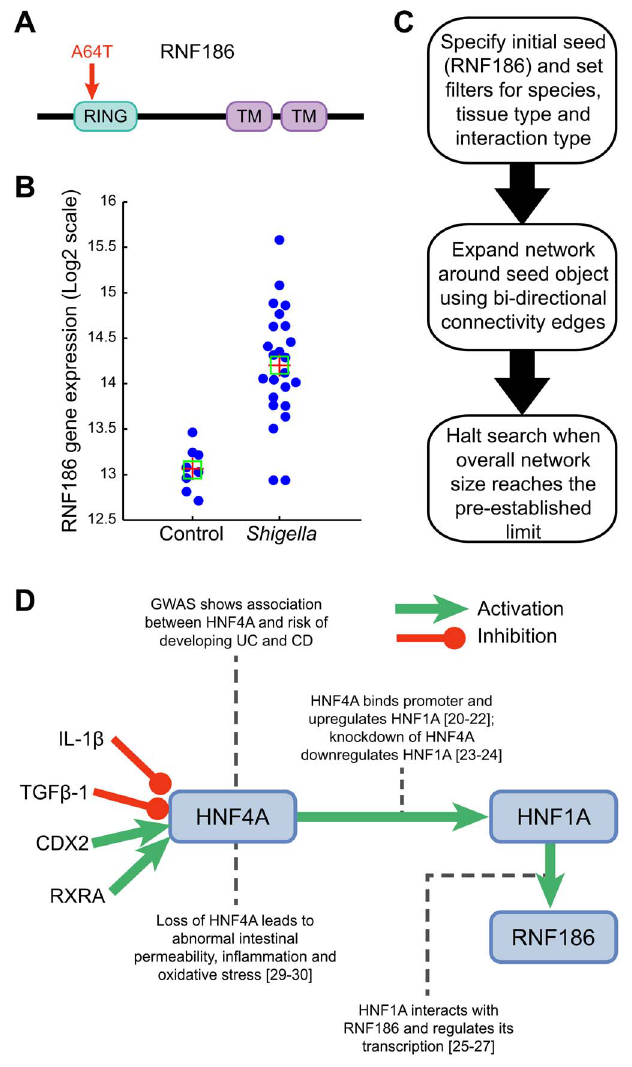
Figure 1. Functional characterization of RNF186. (A) RNF186 encodes a protein with RING domain and two transmembrane domains. E3 ubiquitin-protein ligase activity is intrinsic to the RING domain. This domain contains the disease-coding variant (A64T). (B) RNF186 expression response to S. flexneri in young mice (see also Figure S11). (C) Network building steps. Network is generated by mining multiple sources of interaction databases in Metacore that span human protein-protein, protein-DNA, Protein-RNA and protein-compounds interactions. (D) Transcriptional regulation model for RNF186 . IL1-beta and TGF-beta 1 decrease HNF4A mRNA expression [39–41]. Knockdown of retinoid X receptor, alpha ( RXRA ) down-regulates HNF4A gene expression; RXRA interacts with HNF4A gene [24]. HNF4A is a direct target gene of caudal type homeobox 2 (CDX2); CDX2 increases HNF4A mRNA expression in intestinal epithelial cells [42,43]. HNF4A binds promoter region of HNF1A and up-regulates its expression. HNF1A interacts with RNF186 and regulates its